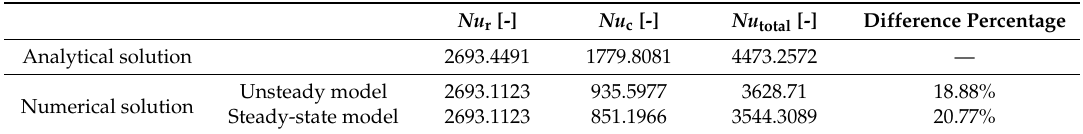
Table 3. Average radiative, convective, and total Nusselt numbers on the kiln surface. Nu r